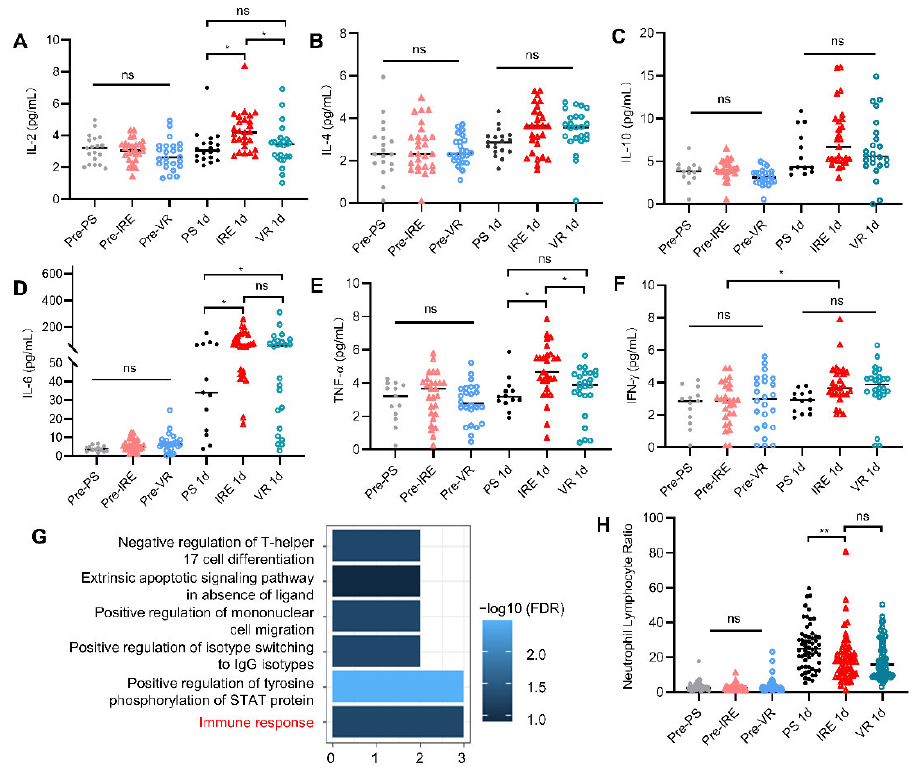
Figure 2. Changes in serum cytokine levels on the first day after treatment in patients treated with indicated procedure: ( A ) Changes in IL-2; ( B ) changes in IL-4; ( C ) changes in IL-10; ( D ) changes in IL-6; ( E ) changes in TNF- α ; ( F ) changes in INF- γ ; ( G ) GO enrichment analysis of the different cytokines; and ( H ) changes in neutrophil–lymphocyte ratio, an immune marker. *, p < 0.05; **, p < 0.01; ns, not significant.